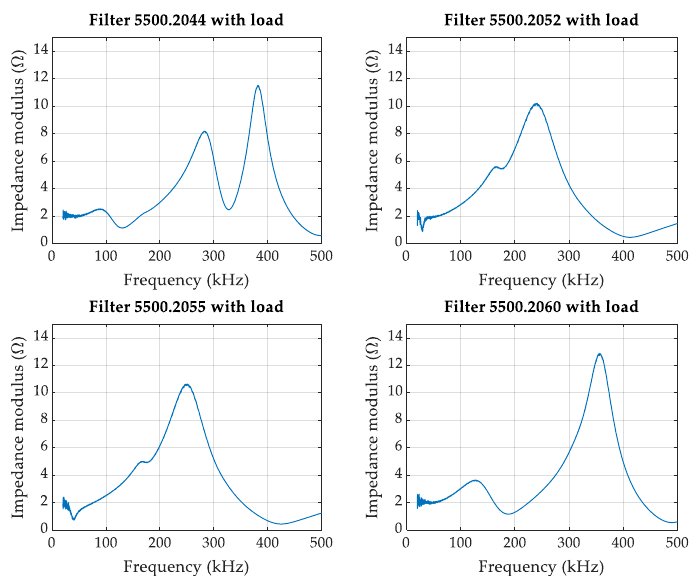
Figure 6. Impedance modulus of the four EMC filters connected to the setup, when a load is connected in L’-N’.